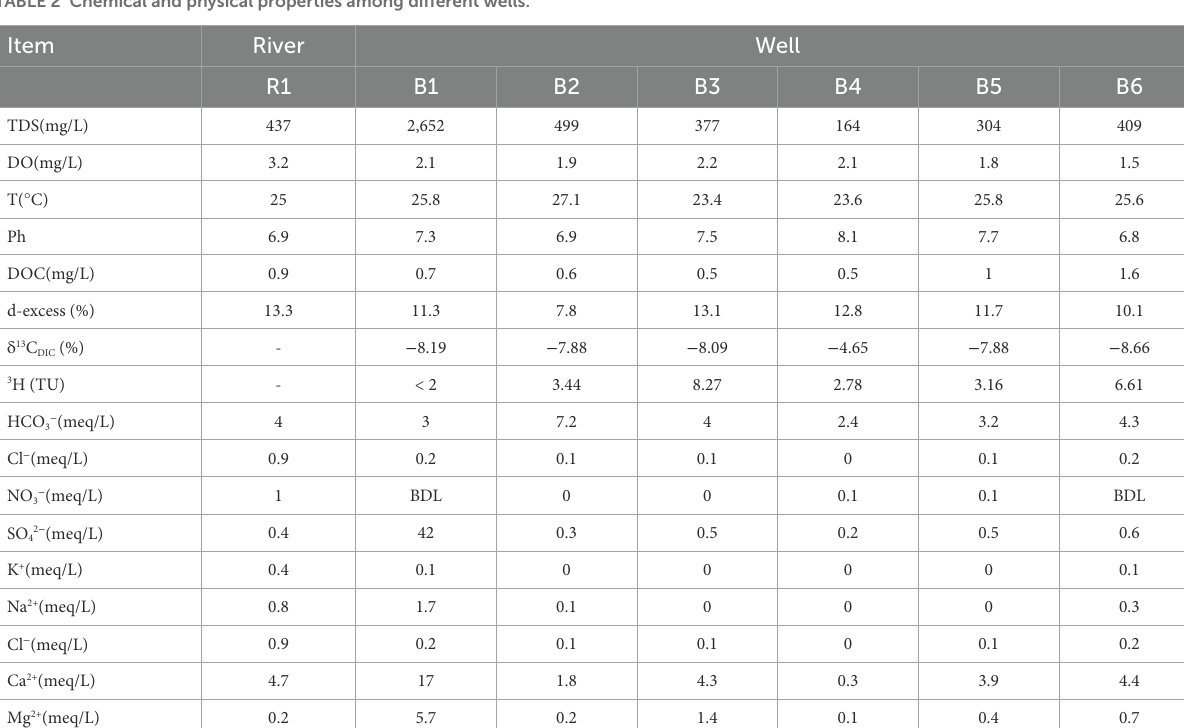
TABLE 2 Chemical and physical properties among different